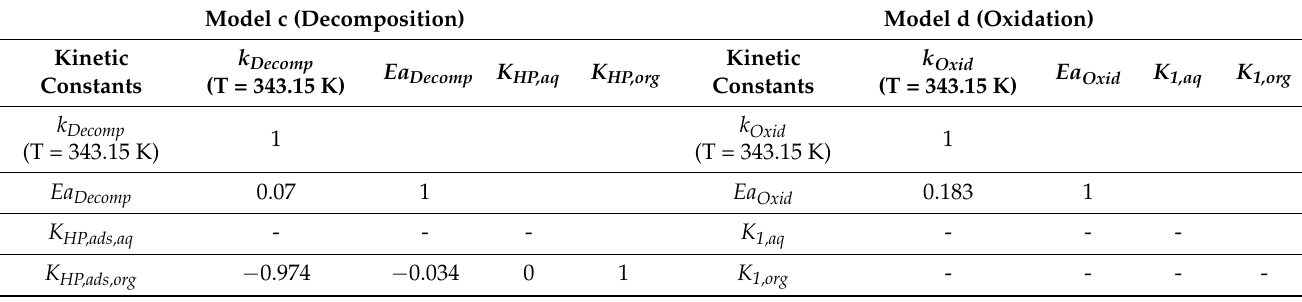
Table 7. Normalized covariance matrix for the estimated kinetic constants for Models c and d for the heterogeneous liquid phase